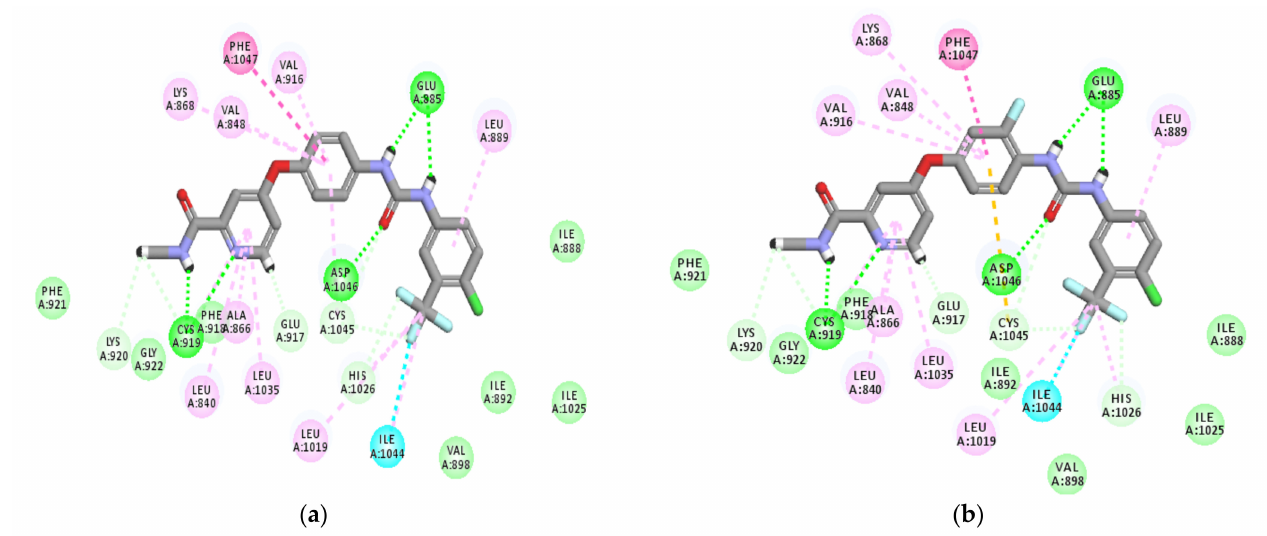
Figure 10. Two-dimensional representation of the interacting mode of sorafenib ( a ) and regorafenib ( b ) with VEGFR kinase. The H-bond interactions are represented by green dotted